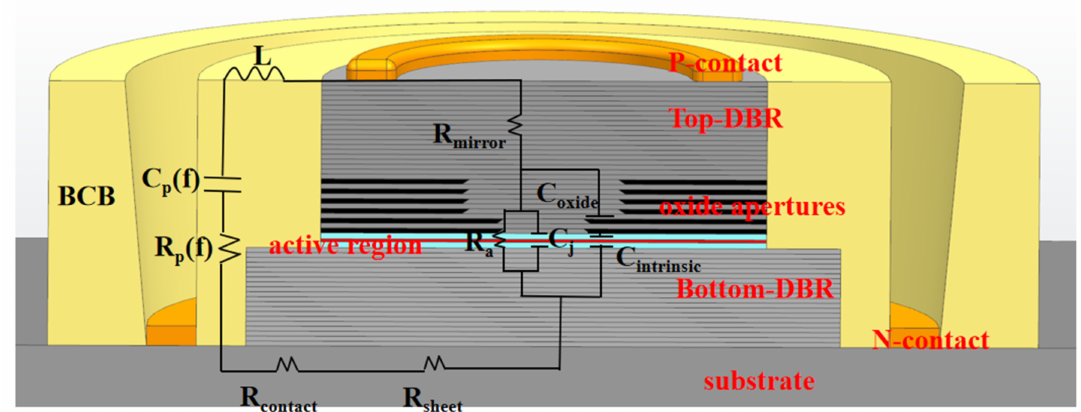
Figure 4. Equivalent electrical circuit model of an oxide-confined top-emitting